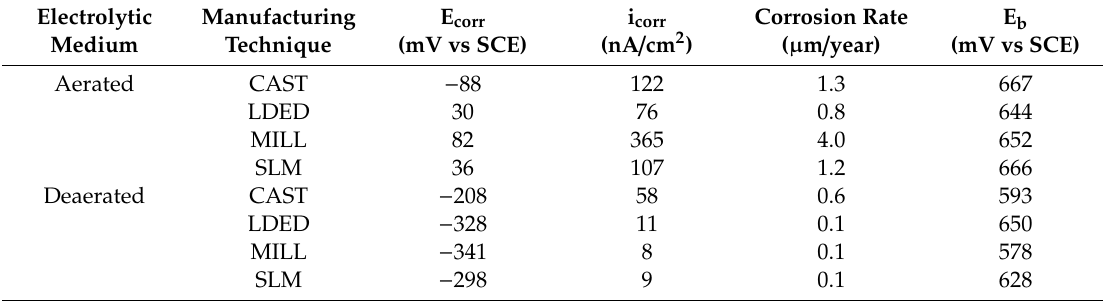
Figure 10. Equivalent corrosion speed (Co) ( A ) and disruptive discharge potential ( B ) of the different manufacturing techniques in aerated and deaerated AS. Error bars indicate the standard error of the mean. Table 6. Summary of the results of the cyclic potentiodynamic polarization (CPCD) tests . Electrolytic